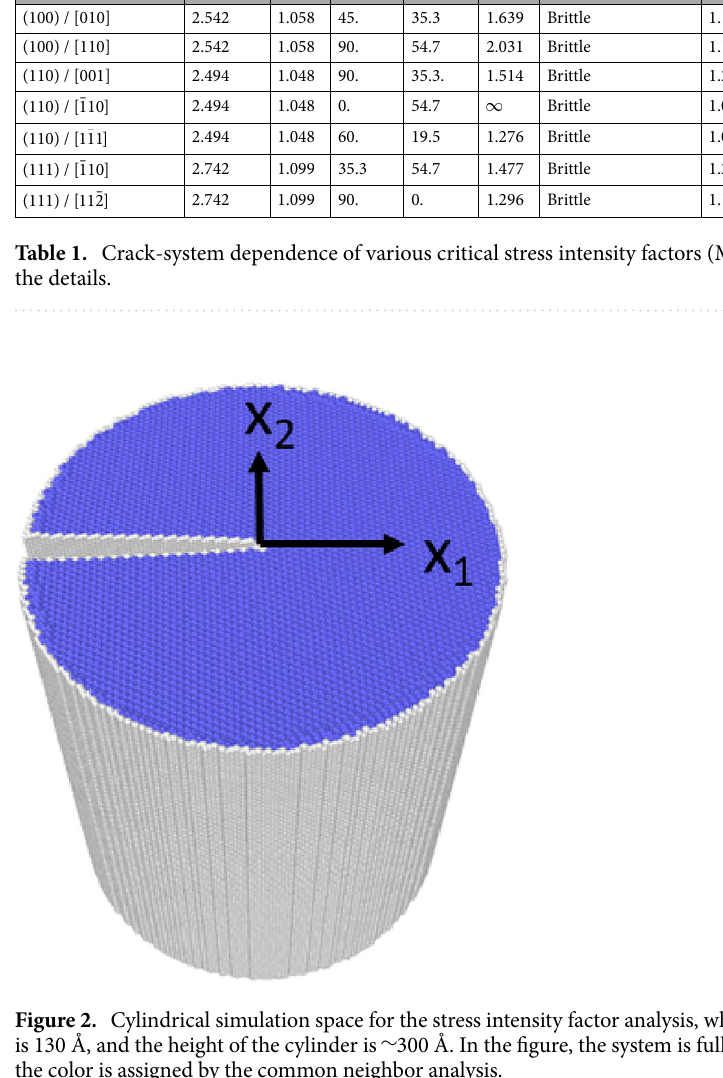
300 Å. In the figure, the system is fully relaxed at K I ∼